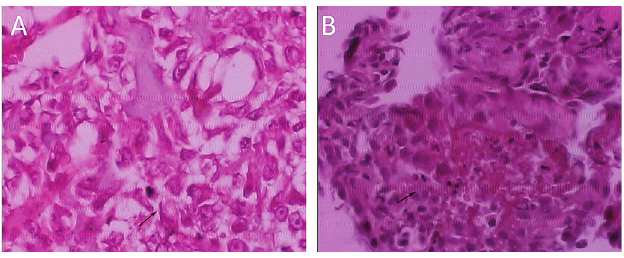
FigurE 3 − A) photomicrography HE 400×: presence of nests of epithelioid osteoblasts, nucleoli and cellular atypia (black arrow); B) photomicrography HE 400×: microcystification with hemorrhage (black arrow) HE: hematoxylin and eosin.